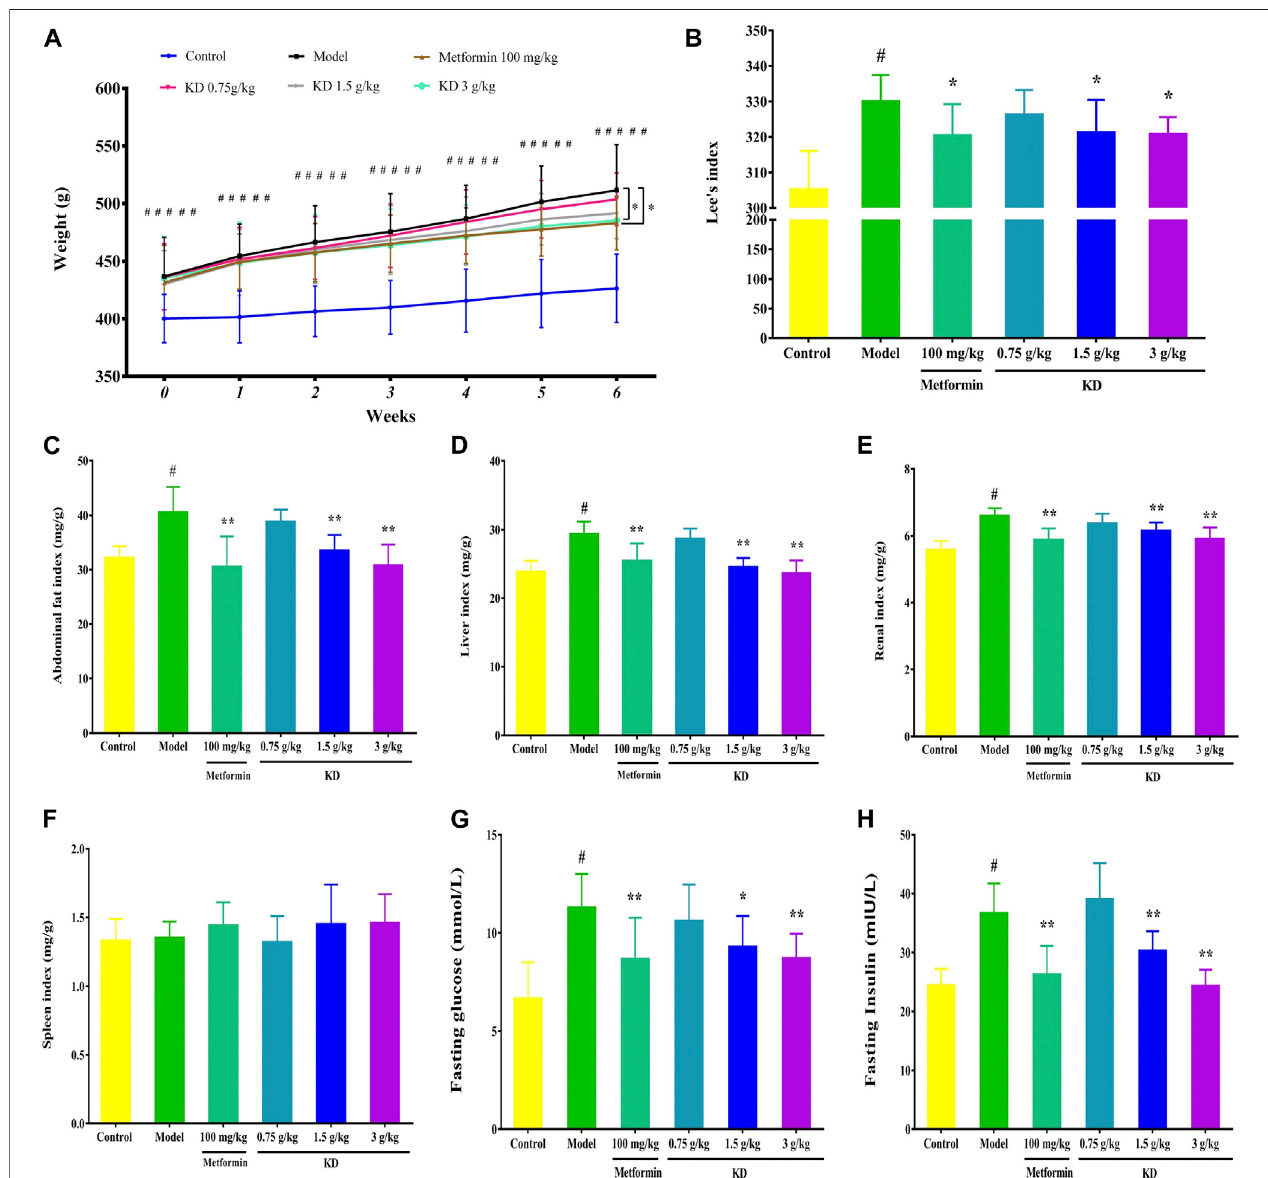
FIGURE9| KDimprovestheobesityandinsulinsensitivityofhigh-fatdiet-fedrats. (A) EffectofKDonthebodyweightsofrats. (B) EffectofKDontheLee ’ sindexes of rats. (C) The abdominal fat indexes of rats. (D) The liver indexes of rats. (E) The renal indexes of rats. (F) The spleen indexes of rats. (G) Fasting glucose in blood. (H) Fasting insulin in blood. (I) Effectof KDon the oral glucose tolerance in rats. (J) Effect ofKD on the insulin tolerance in rats. (K) Insulin sensitivity index. (L) HOMA-IR. (M) The serum triglyceride levels of rats. (N) The serum cholesterol levels of rats. (O) The serum LDL-C levels of rats. (P) The serum HDL-C levels of rats. Data were presented as mean ± SD ( n (cid:2) 7 – 10 in each group). # P < 0.01 compared with the control group, * P < 0.05, ** P < 0.01 compared with the model